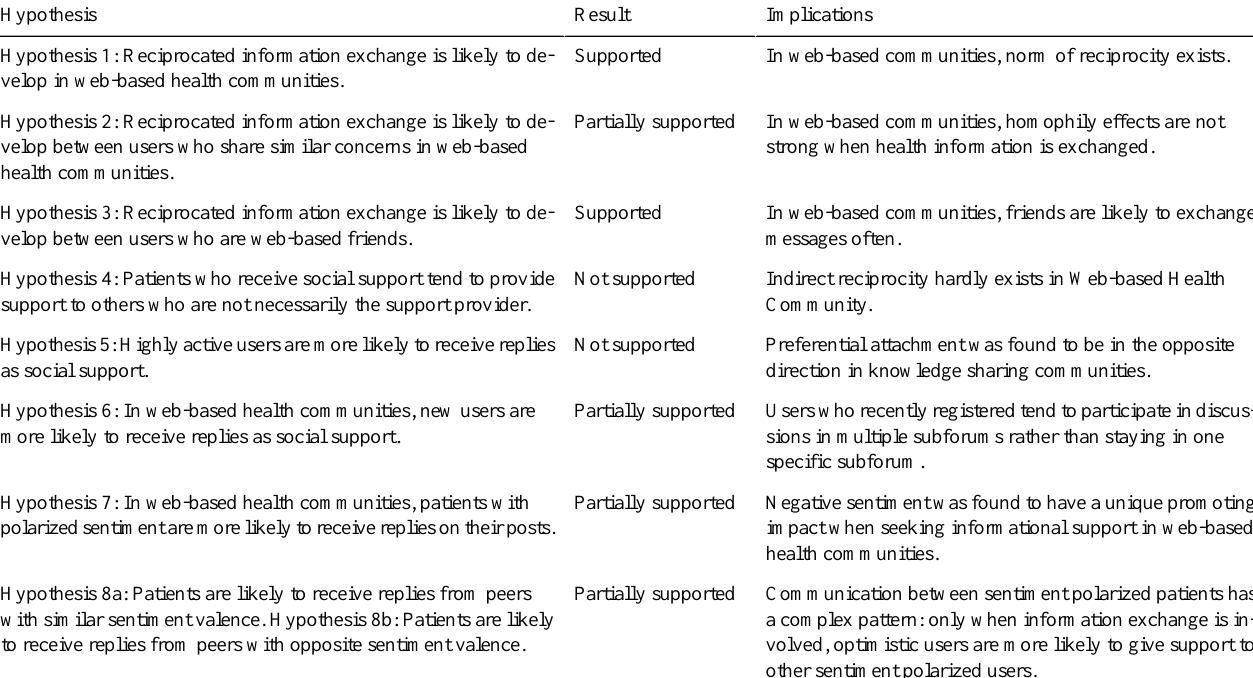
Table 5. Summary of research hypotheses and results.